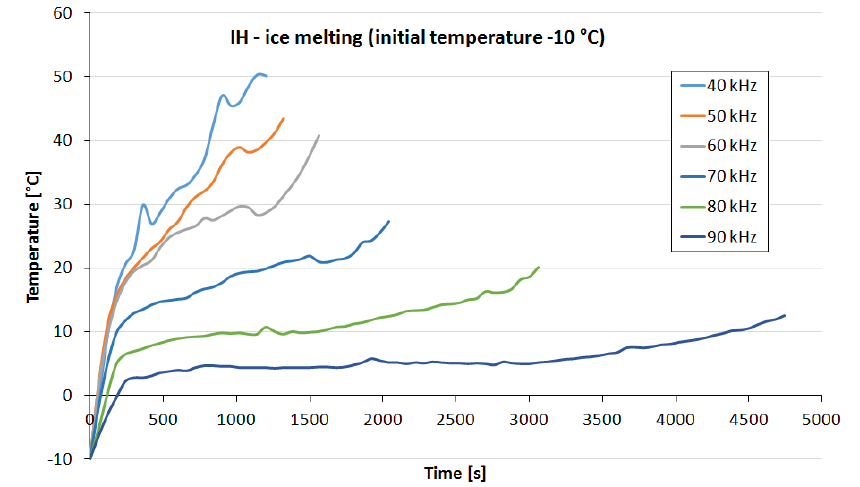
Figure 16. Temperature of IH device surface vs. time at different operating frequencies for an initial temperature of −10 °C.